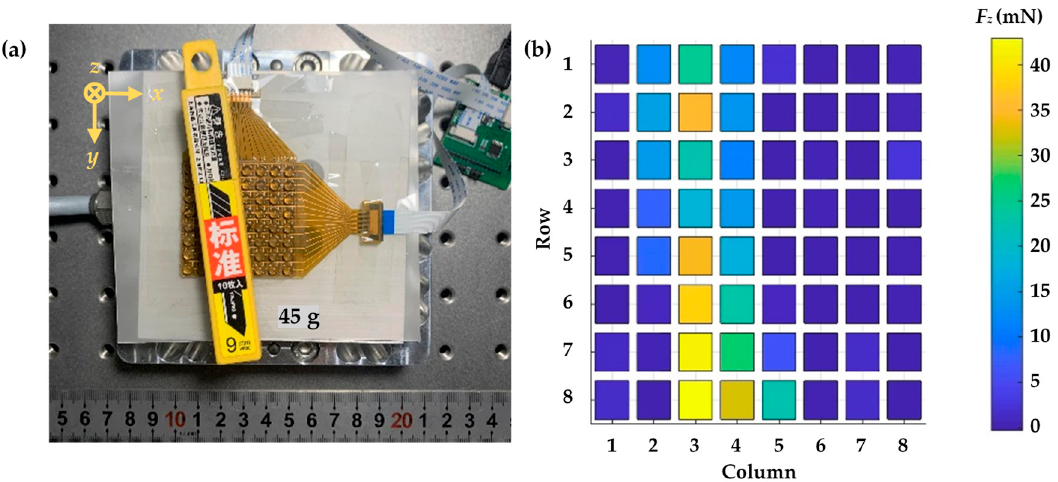
Figure 8. Normal pressure distribution test when a blade box (45 g) rested on the sensing array: ( a ) Overview of experimental setup; ( b ) Real-time overall pressure distribution.